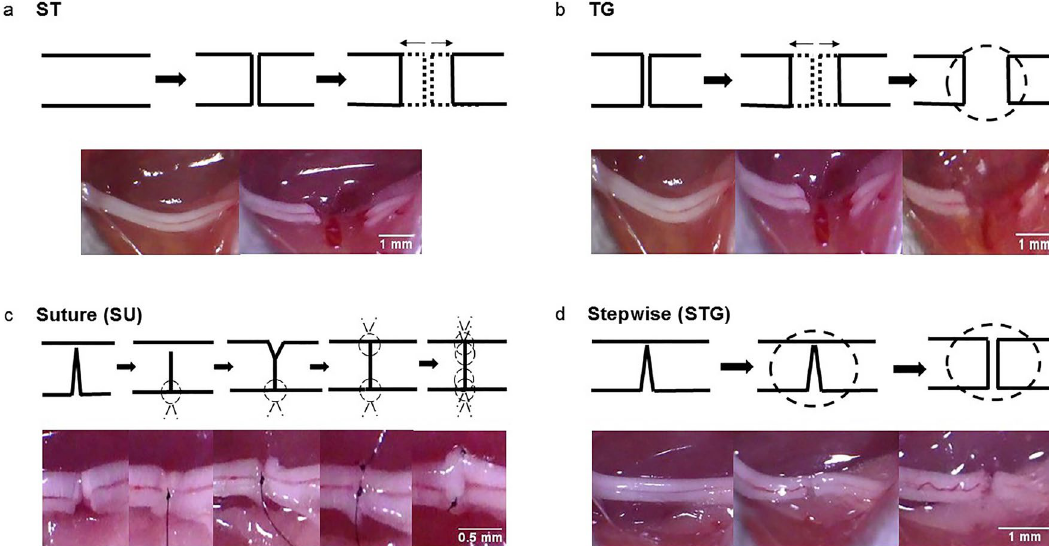
Figure 8. Experimental groups with schematic surgical steps (top panel) and representative gross nerve images (lower panel) of surgical procedures in different nerve transection methods. Experimental groups are ( a ) Simple Transection (ST), ( b ) Transection & Glue (TG), ( c ) Stepwise Transection and Sutures (SU), and ( d ) Stepwise Transection and Glue (STG). The complete transection of the nerve was confirmed under direct microscopic